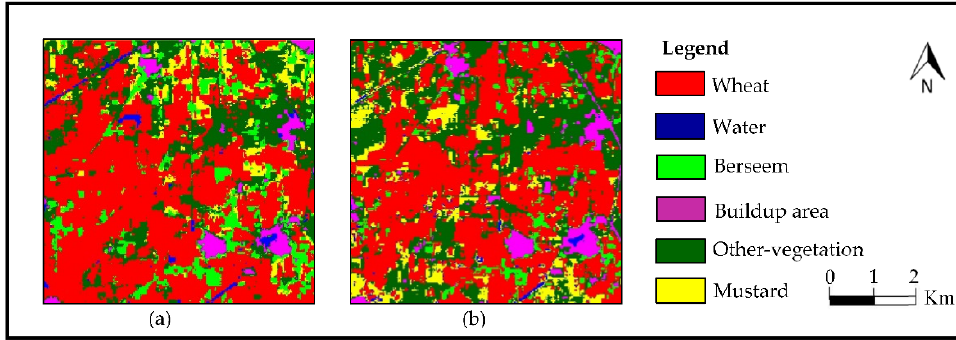
Figure 4. Classified output of ( a ) U-Net-based deep learning, ( b ) RF-based machine learning. As ENVI’s U-Net (deep learning v1.1, ENVI v5.6) is in the initial stage of